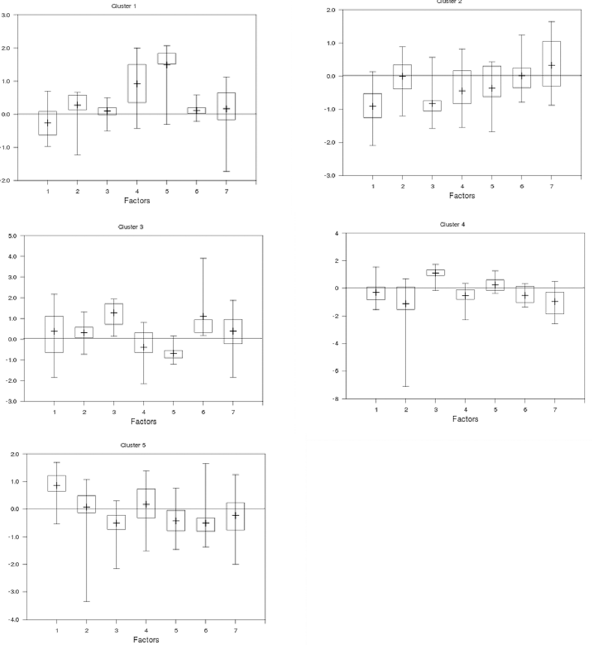
Fig 1. Distributions of district scores on seven factors. Distribution of social vulnerability scores from factor analysis for districts classified into five clusters (using NbClust) allowing evaluation of the influence of each respective social vulnerability factor on each cluster. For each cluster of districts, vertical lines indicate the mean (central cross bar) and maximum and minimum factor scores and boxes delineate quartile factor scores across all seven factors in each cluster of districts. Factor 1- Water Quality/Medical Proximity; Factor 2- Food Quality; Factor 3- Food Quantity; Factor 4- Displaced Populations; Factor 5 – Disabled and Dependent Populations; Factor 6 – Access to Land and Free Medical Care; Factor 7- Lack of Material